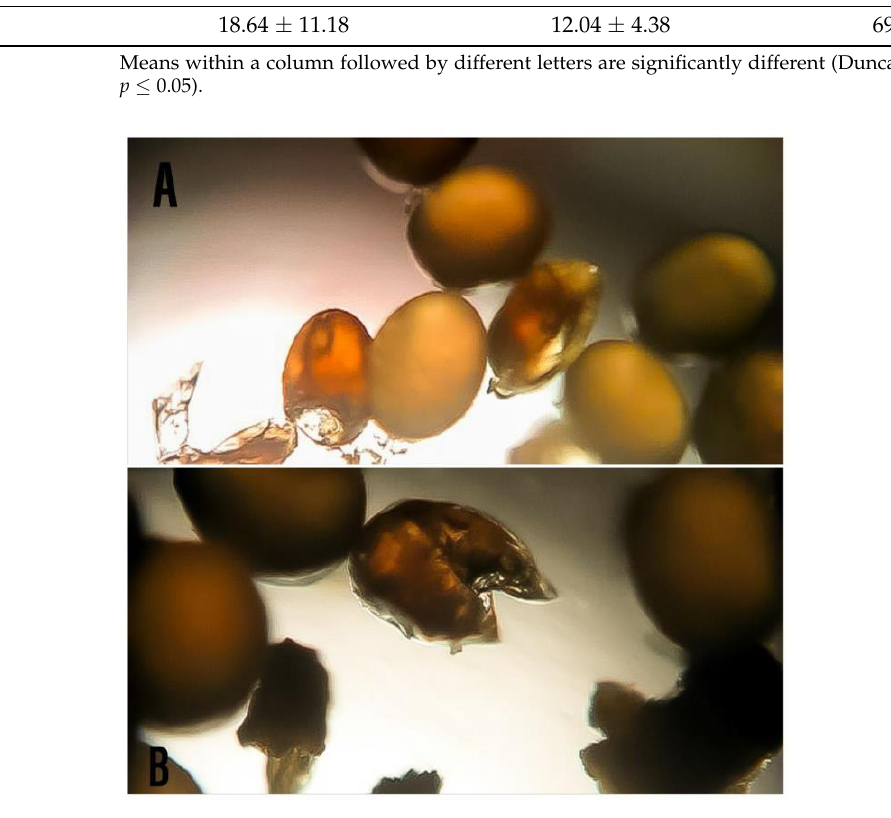
Figure 3. Broken eggs ( A , B ) as evident of predation of earwigs on R. annulatus eggs. Table 2. The number of larvae consumed by adult earwigs present in each ratio after 24 h under laboratory conditions.